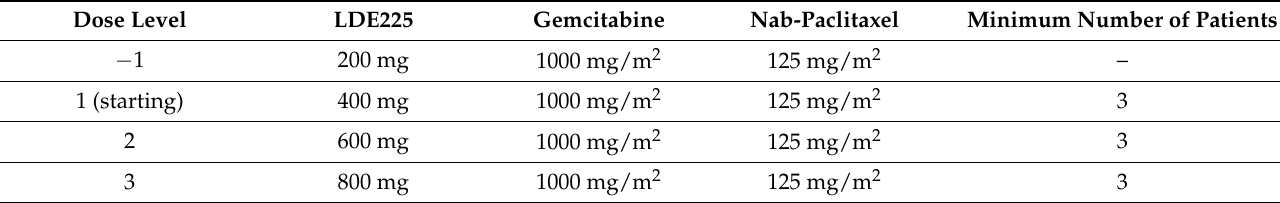
Table 2. Dose escalation scheme phase